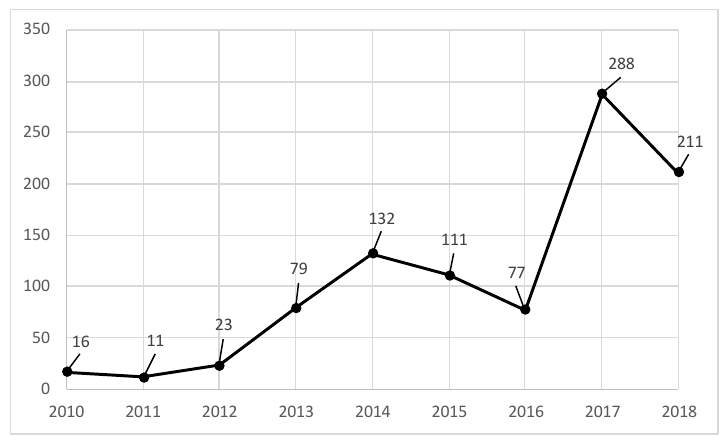
Figure 5. Number of CubeSats launched per